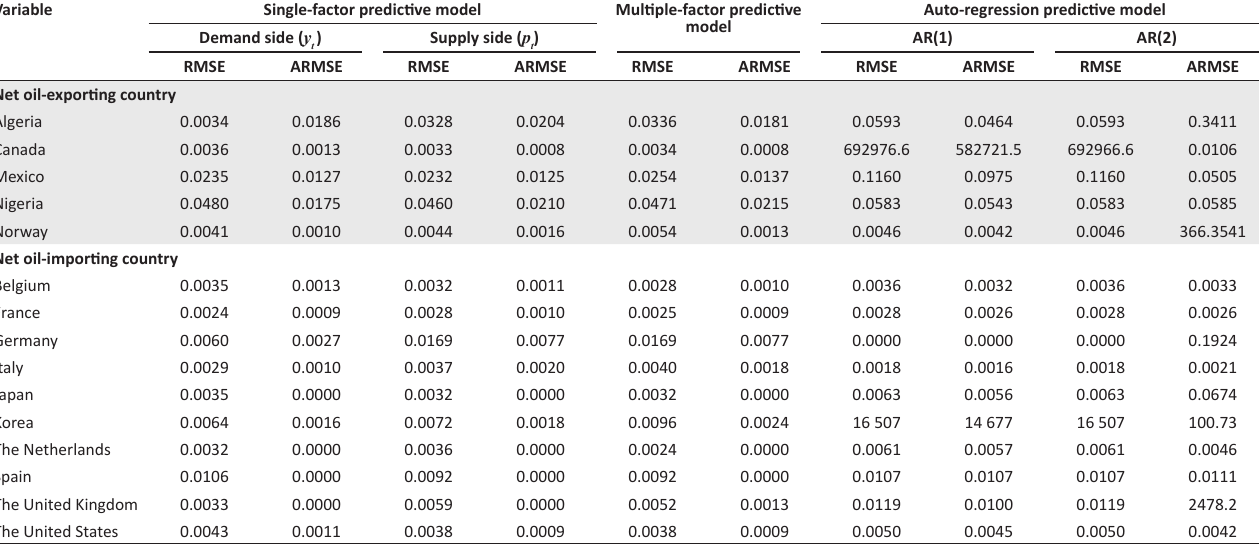
RMSE, root mean square error; ARMSE, adjusted root mean square error; k,k th period ahead; AR,